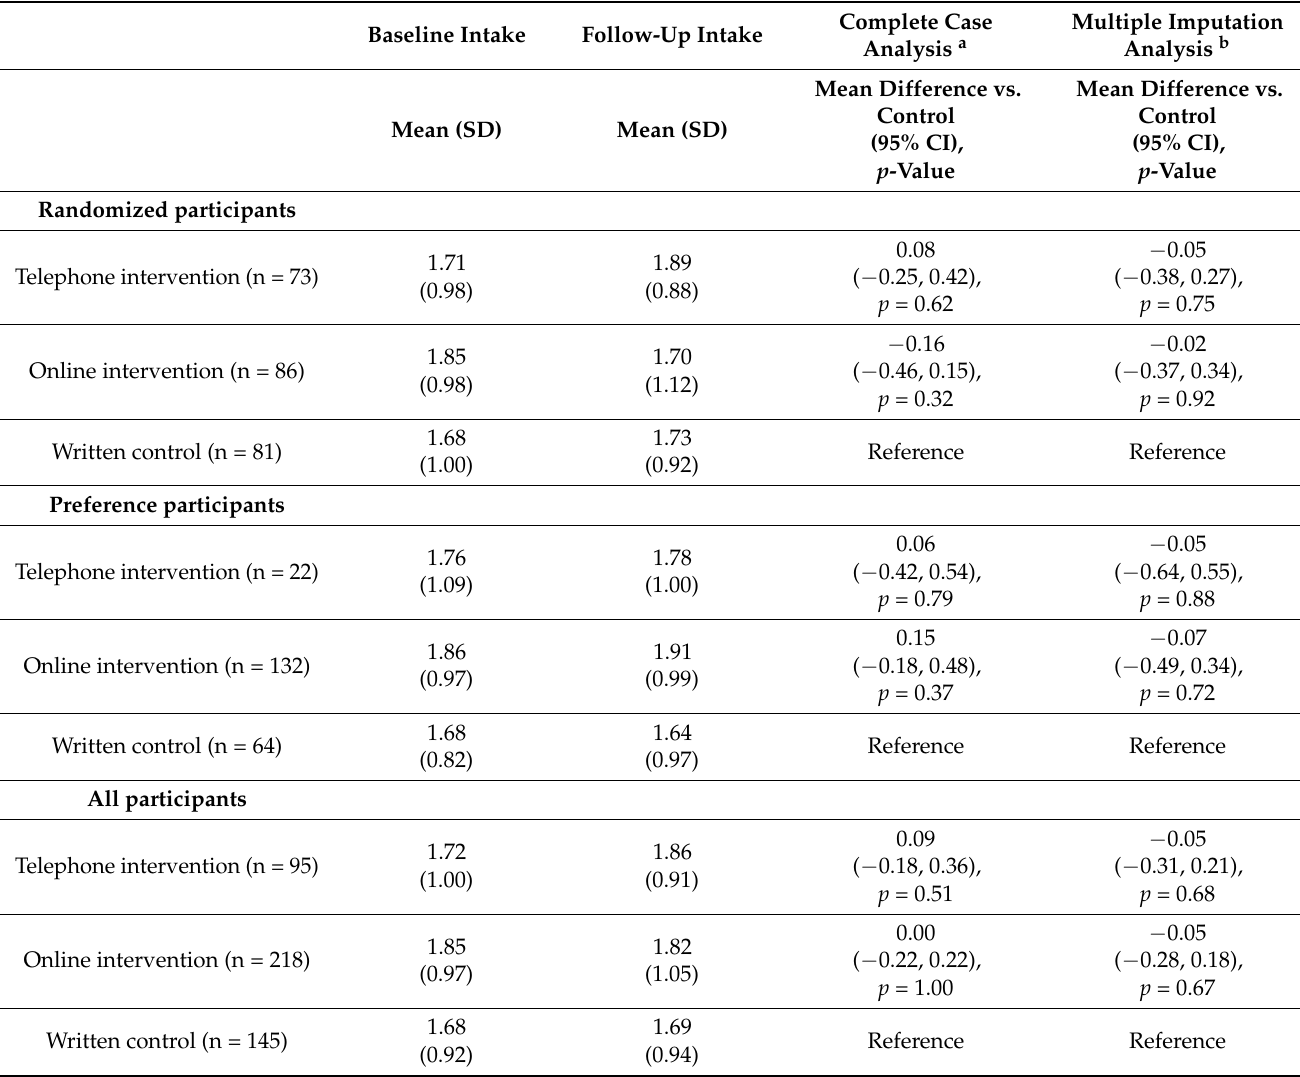
Table 4. Change in parent consumption of fruit (mean daily